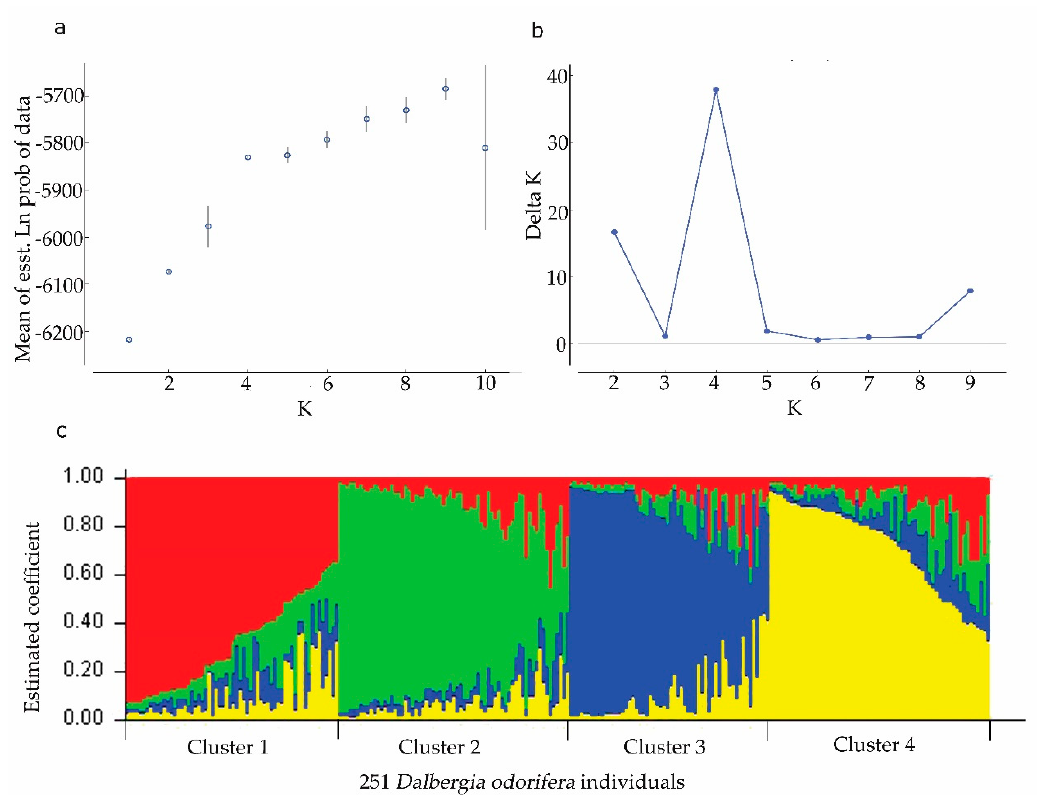
Figure 1. Results of STRUCTURE analysis for 251 Dalbergia odorifera individuals based on microsatellite data. ( a ) Estimation of population using mean of estimated lnP(D) (log probability of data) with cluster number (K) ranged from one to ten. ( b ) Estimation of population using lnP(D)-derived delta K with cluster number (K) ranged from one to ten. ( c ) Four estimated clusters of the 251 D. odorifera individuals presented with different colors inferred by STRUCTURE analysis. Clusters 1–4 were presented by red, green, blue, and yellow, respectively. Each bar represented an individual, in which, different color represents the estimated membership coefficients using the Q statistic.